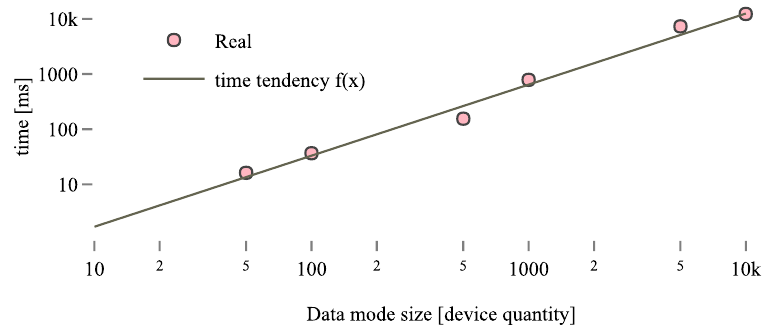
Figure 9. The time growth trend when we increase the number of devices (the axes are in logarithmic